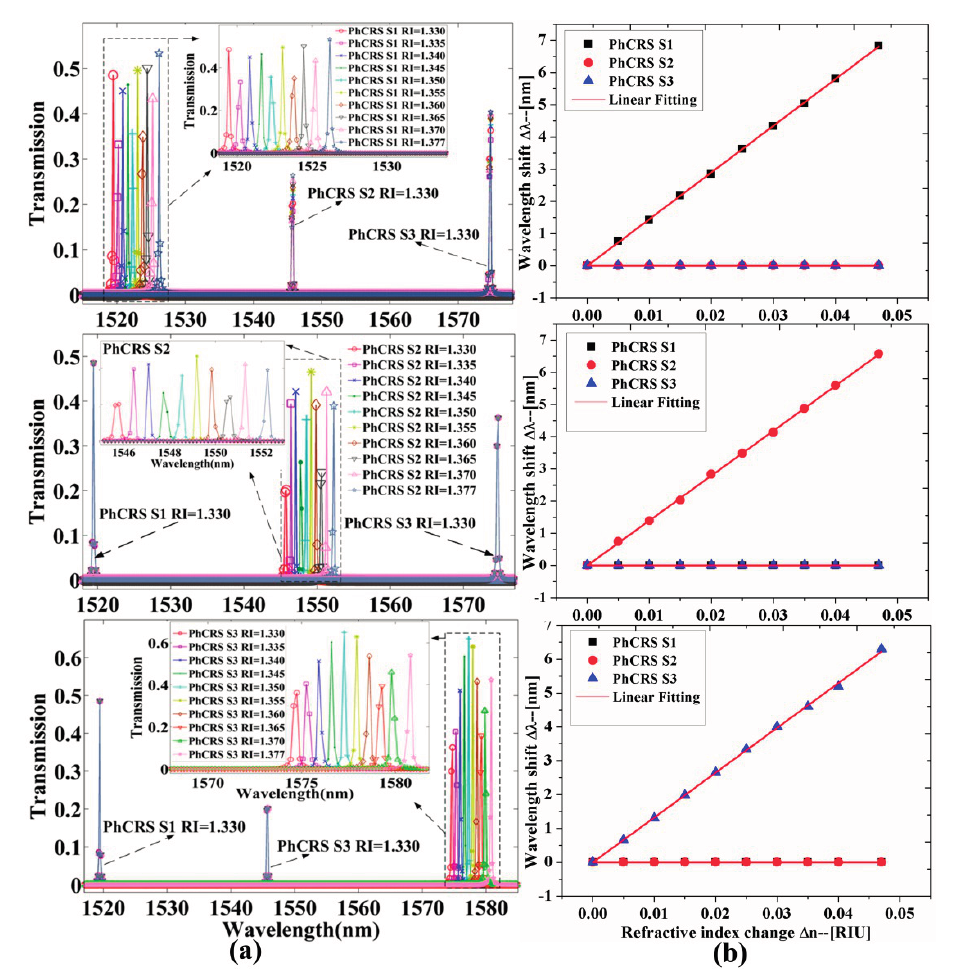
Figure 3. ( a ) The transmission spectra of three ring-slot cavities (PhCRSS1, PhCRSS2, PhCRSS3) when the RI of functionalized area of one sensor is changed and the others are not; ( b ) Wavelength shift Δλ as a function of the RI of functionalized area